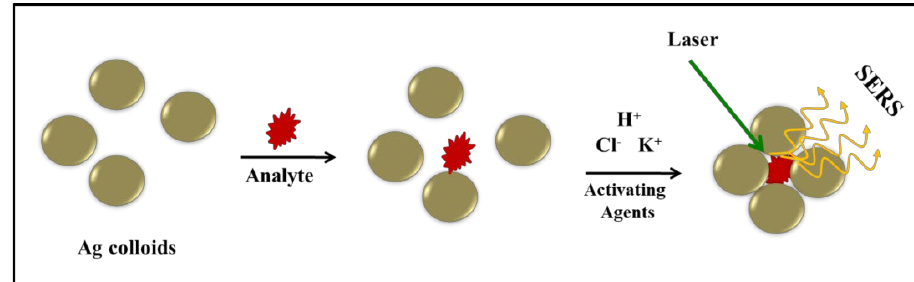
Figure 2. Illustration of the SERS mechanism using Ag colloids and activating agents.